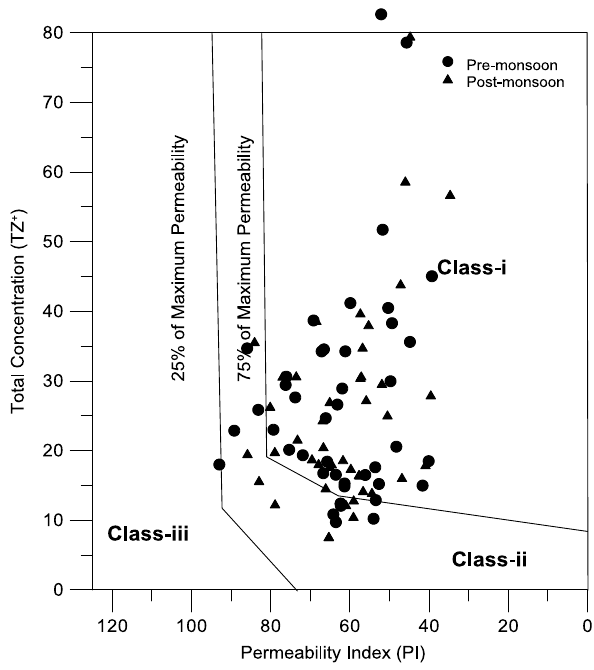
Fig. 18 Doneen (1964) classified irrigation water based on the per- meability